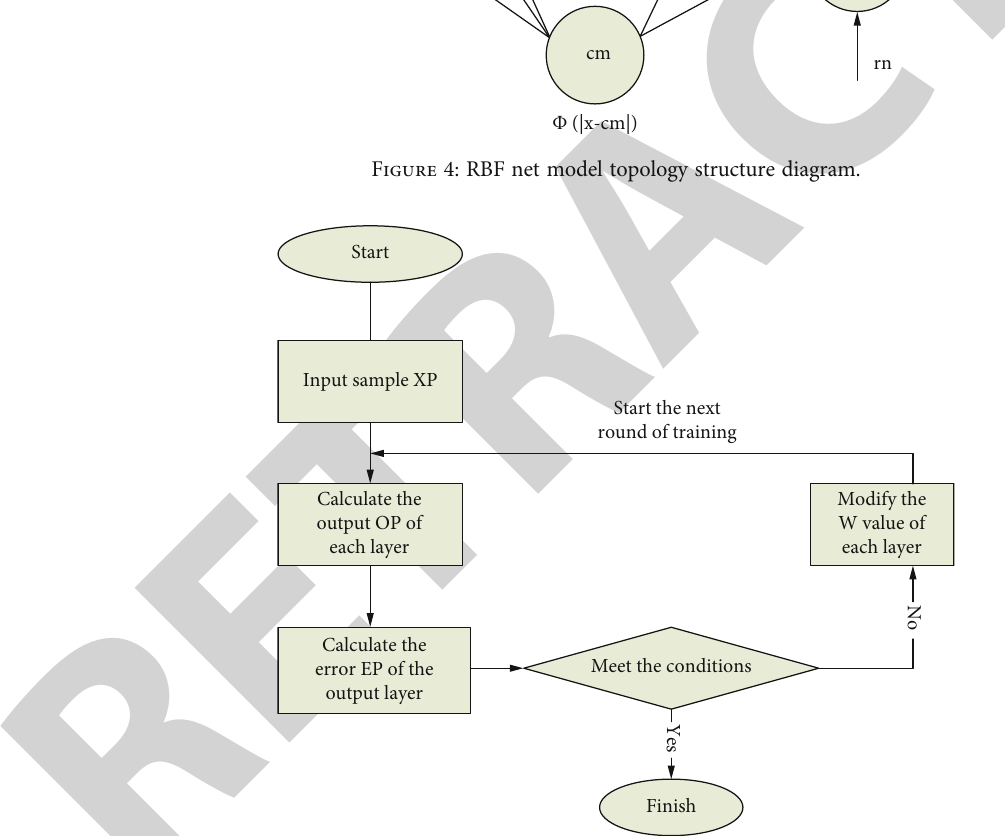
Figure 5: BP algorithm fl ow